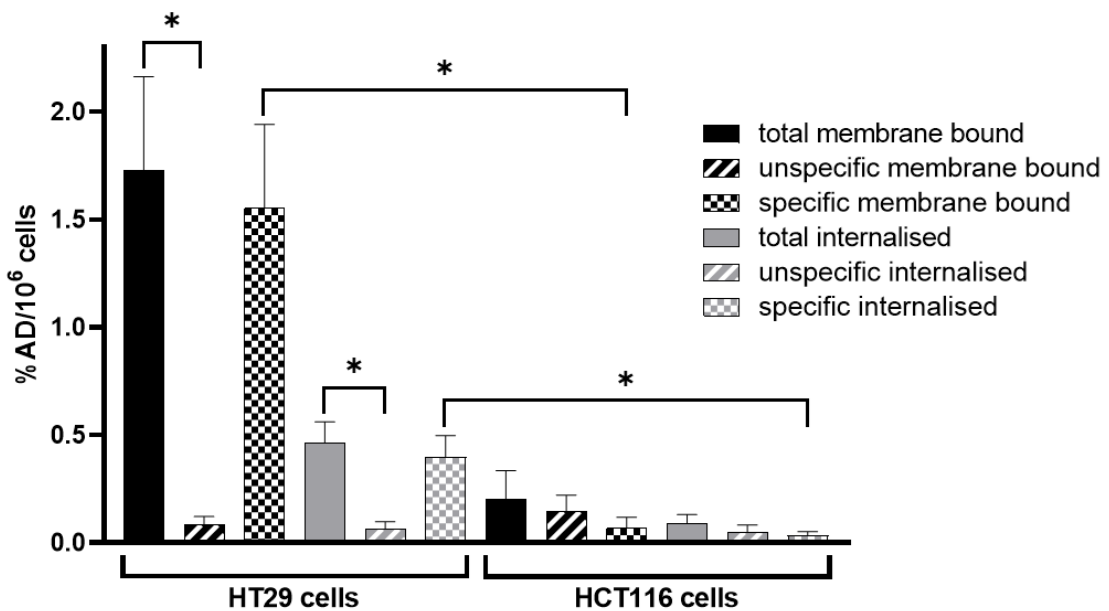
Figure 1. Total, unspecific, and specific membrane binding and internalisation of [ 68 Ga]Ga-Pentixafor in HT29 and HCT116 cells are shown. At least three independent experiments were performed in triplicate. Data are plotted as % applied dose normalised to 1 × 10 6 cells (%AD/10 6 cells) and presented as mean ± SD. Datasets that are significantly different ( p < 0.05) are marked with an asterisk